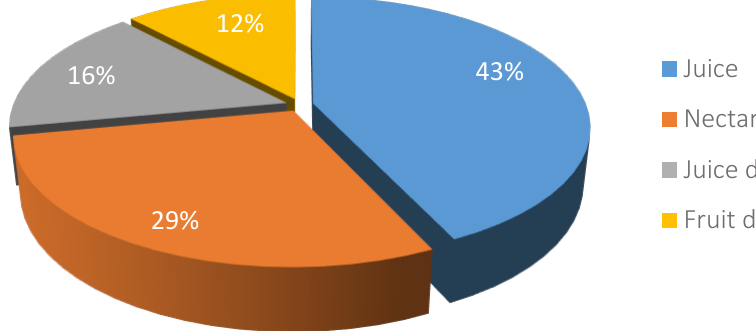
Figure 5. Structural analysis of juice market products